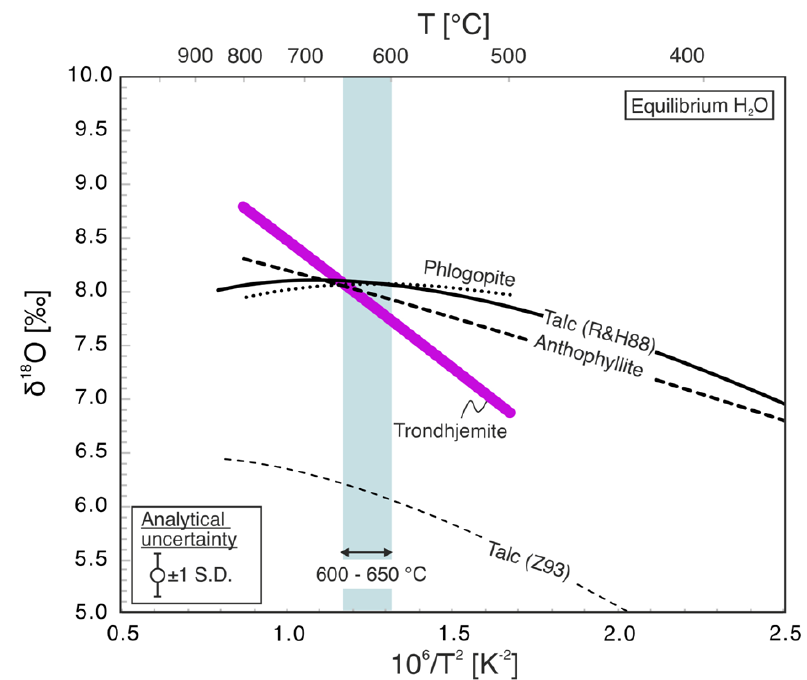
Figure 11. Calculated δ 18 O of fluids that could have been in equilibrium with the mineral samples (indicated) and with the trondhjemite sample from this study. The fluid compositions were calculated from the measured δ 18 O values of the samples (inset shows measurement precisions), in conjunction with available mineral-water fractionation factors [42–45]. The δ 18 O of the trondhjemite sample was based on modal abundances of 80.61% albite, 18.99% quartz, and 0.4% biotite in the sample, as determined by XRD analysis. The suggested temperature range for talc formation from the phase relations of the dunite bulk-rock composition is shown by the vertical bar (600–650 °C; see text). R&H88 = Richter and Hoernes [42]; Z93 = Zheng [43]. The Δ’ 17 O 0.528 values of the talc, anthophyllite, and phlogopite samples are similar to those of most igneous rocks and minerals (e.g., [21]), including the trondhjemite sample. This observation confirms that fluids that were involved in the formation of these particular samples were derived from magmatic waters with a Δ’ 17 O 0.528 of about −40 ppm. In contrast, rocks that have become hydrothermally altered by fluids that were derived from seawater or from meteorite waters, for example, typically have δ 18 O and Δ’ 17 O 0.528 values that are lower and higher than igneous rocks, respectively (e.g., [21,46].